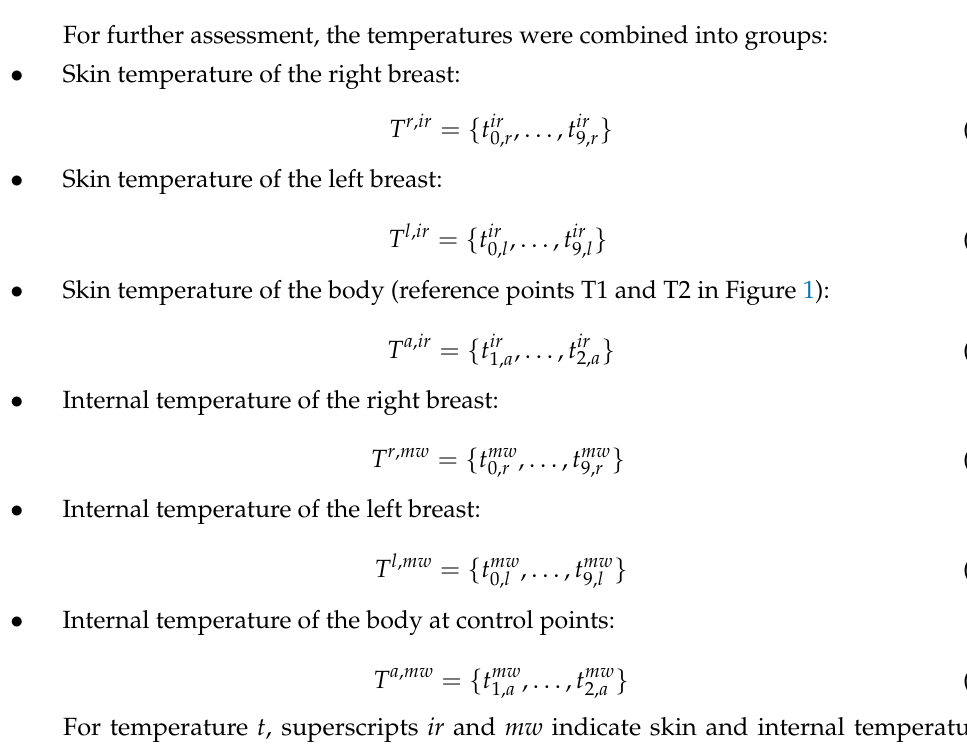
Figure 2. Interface of the MWR2020 software. Temperature measurements of a healthy patient.